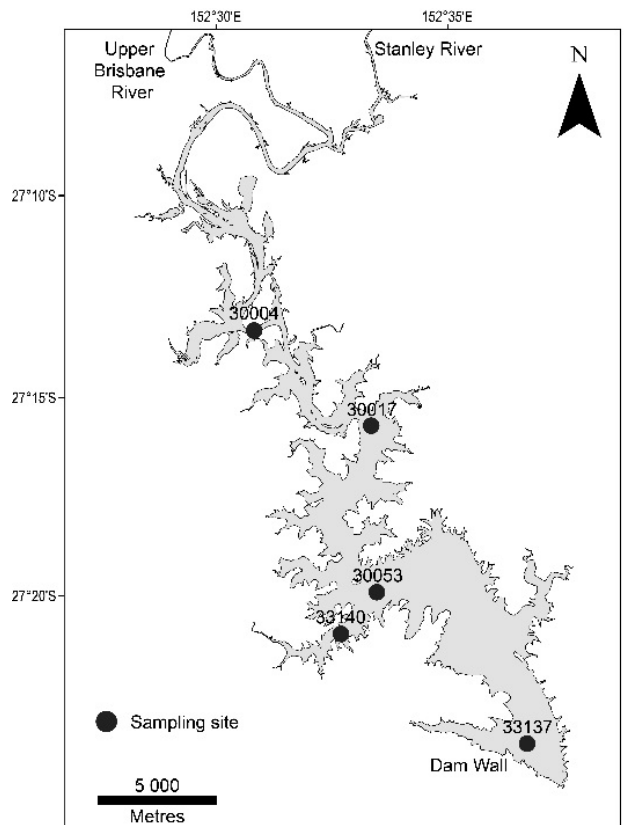
Figure 1. Lake Wivenhoe and sampling